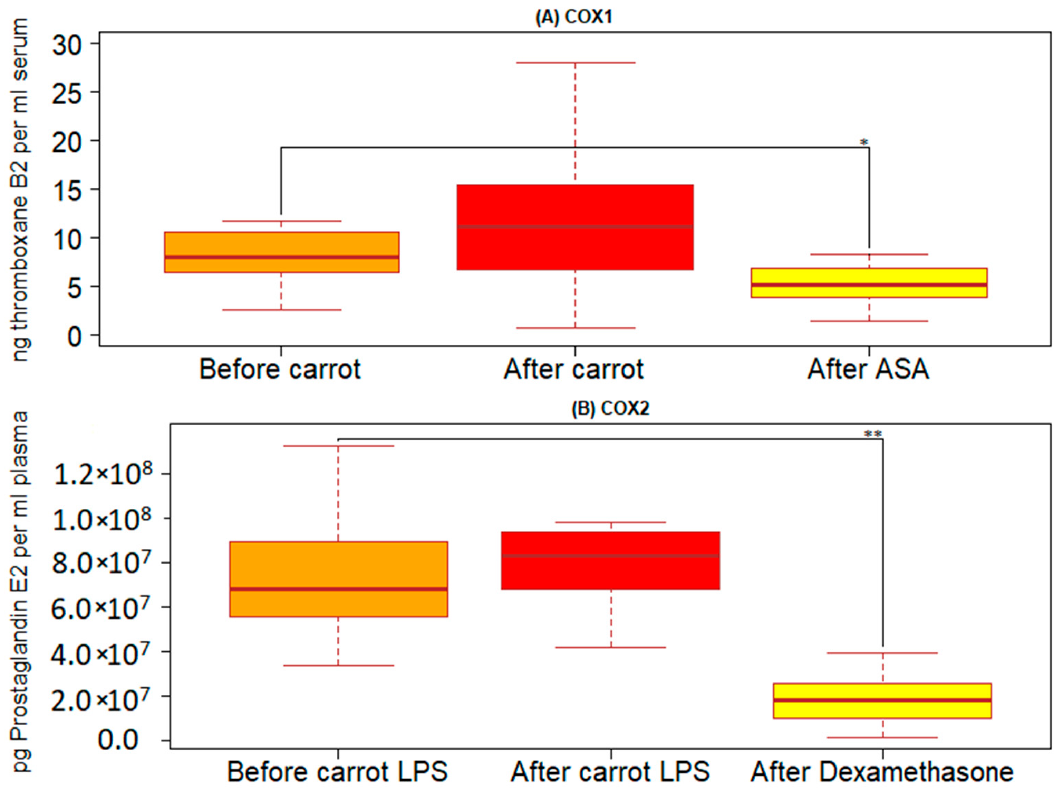
Figure 2. ( A ) TXB2 serum level in blood samples after the clotting process. Orange box blood samples taken before intake of carrot juice. Red box blood samples taken after intake of carrot juice.